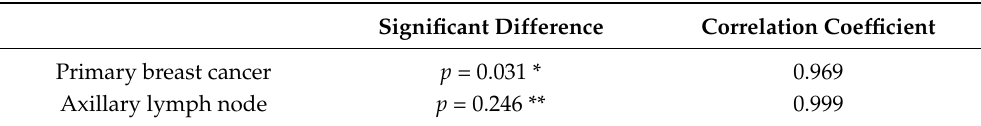
Table 3. Results of the statistical analysis of the SUVmax on the 18 F-FLT PET/CT and 18 F-FDG PET/CT for treatment-naive